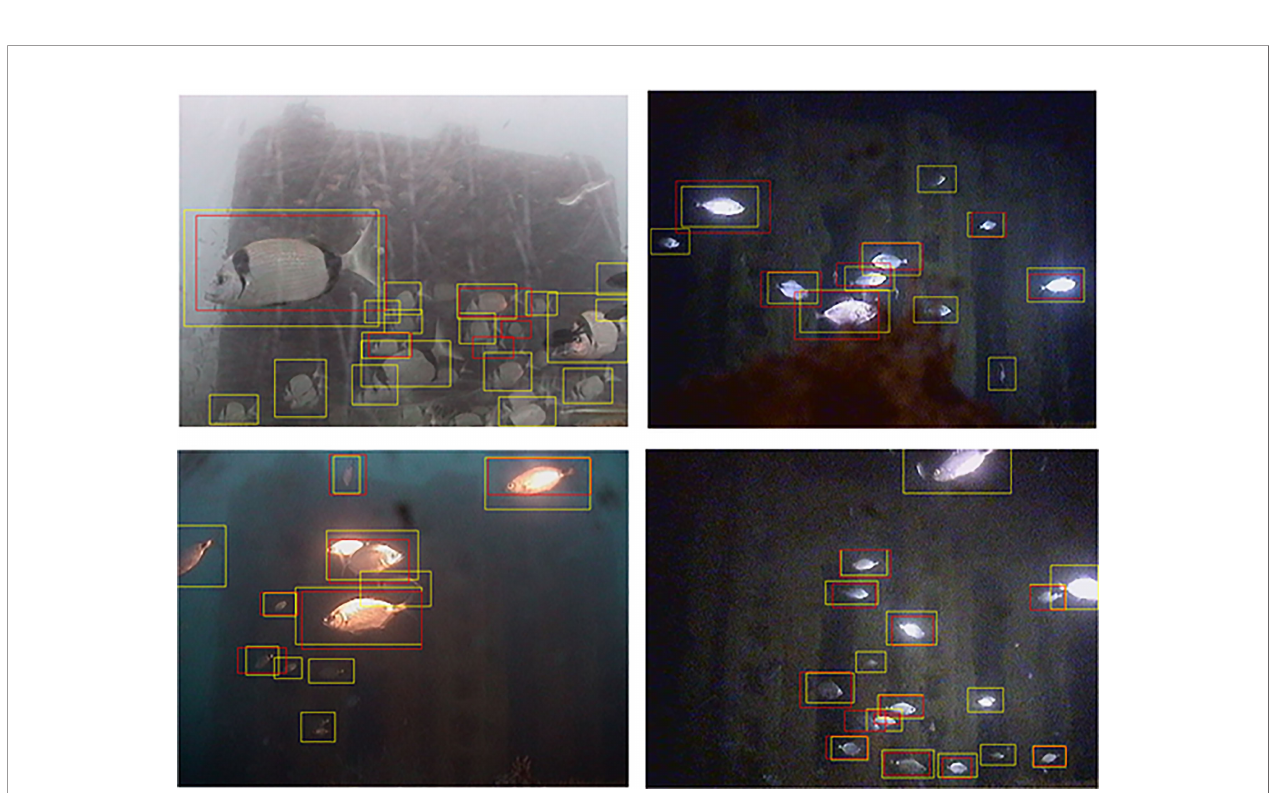
FIGURE 8 | Four examples of automated fi sh detection. The red boxes represent the ground-truth bounding boxes, while the yellow boxes represent the automated fi sh